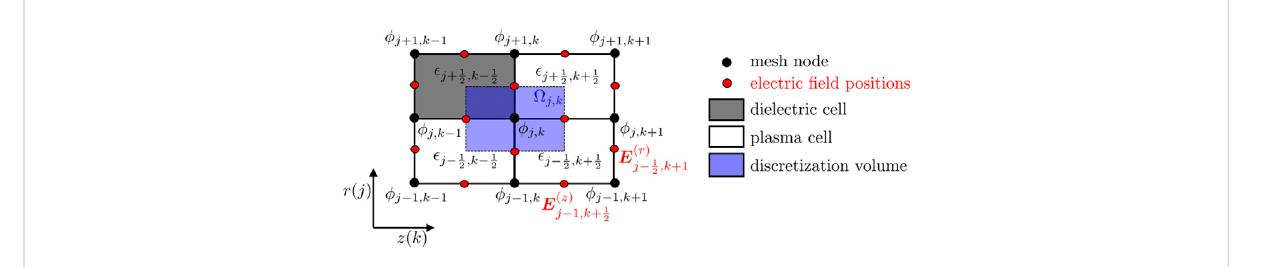
FIGURE 4 Scheme representing the Poisson equation discretization used in the model.